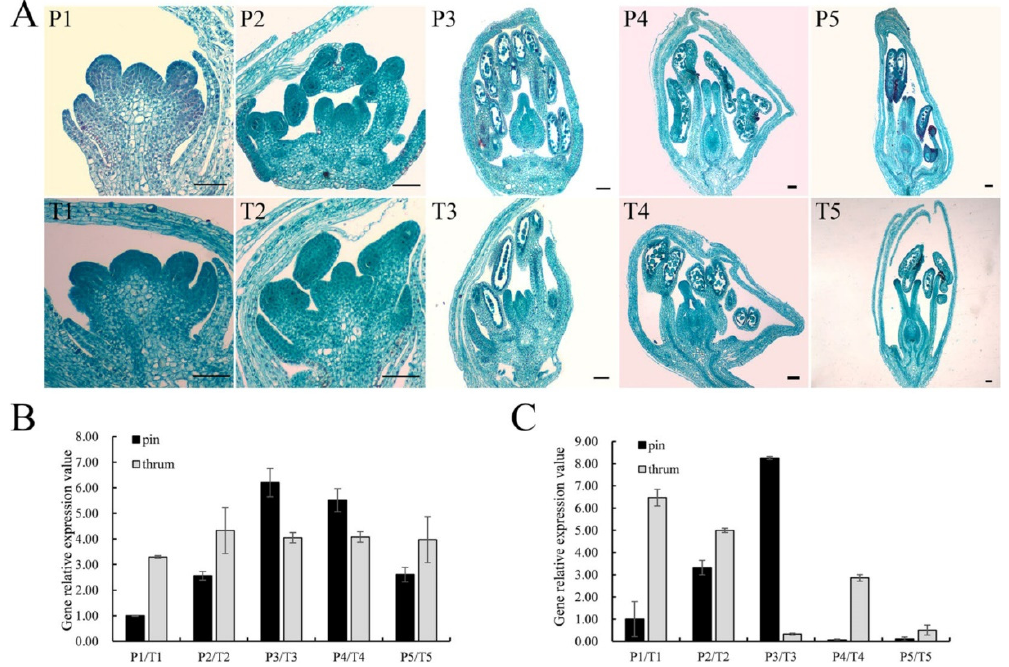
Figure 5. Morphology, FaesPI_1, and FaesPI_2 expression in different development stage distylous flowers of F. esculentum . ( A ) Cytomorphological section of thrum and pin floral buds at different development stages; P1–P5: pin floral bud differentiation; P1: stamen primodium appearance; P2: filament rapid elongating; P3: microspore tetrad formation; P4: mononuclear microspore and tepal enclosing; P5: maturity floral bud with mature pollen and embryo sac before bloom; T1–T5: Cytomorphological section of the thrum floral buds; T1: stamen primodium appearance; T2: filament elongation; T3: meiosis of microspore mother cells; T4: periphery of mononuclear microspore, tepal enclosing; T5: maturity floral buds with mature pollen and embryo sac before bloom; ( B ) FaesPI_1 expression at pin and thrum floral buds were separately detected by qRT-PCR during floral bud differentiation; ( C ) FaesPI_2 expression at pin and thrum floral buds were separately detected by qRT-PCR during floral bud differentiation . Scale bar: 100 μ m.